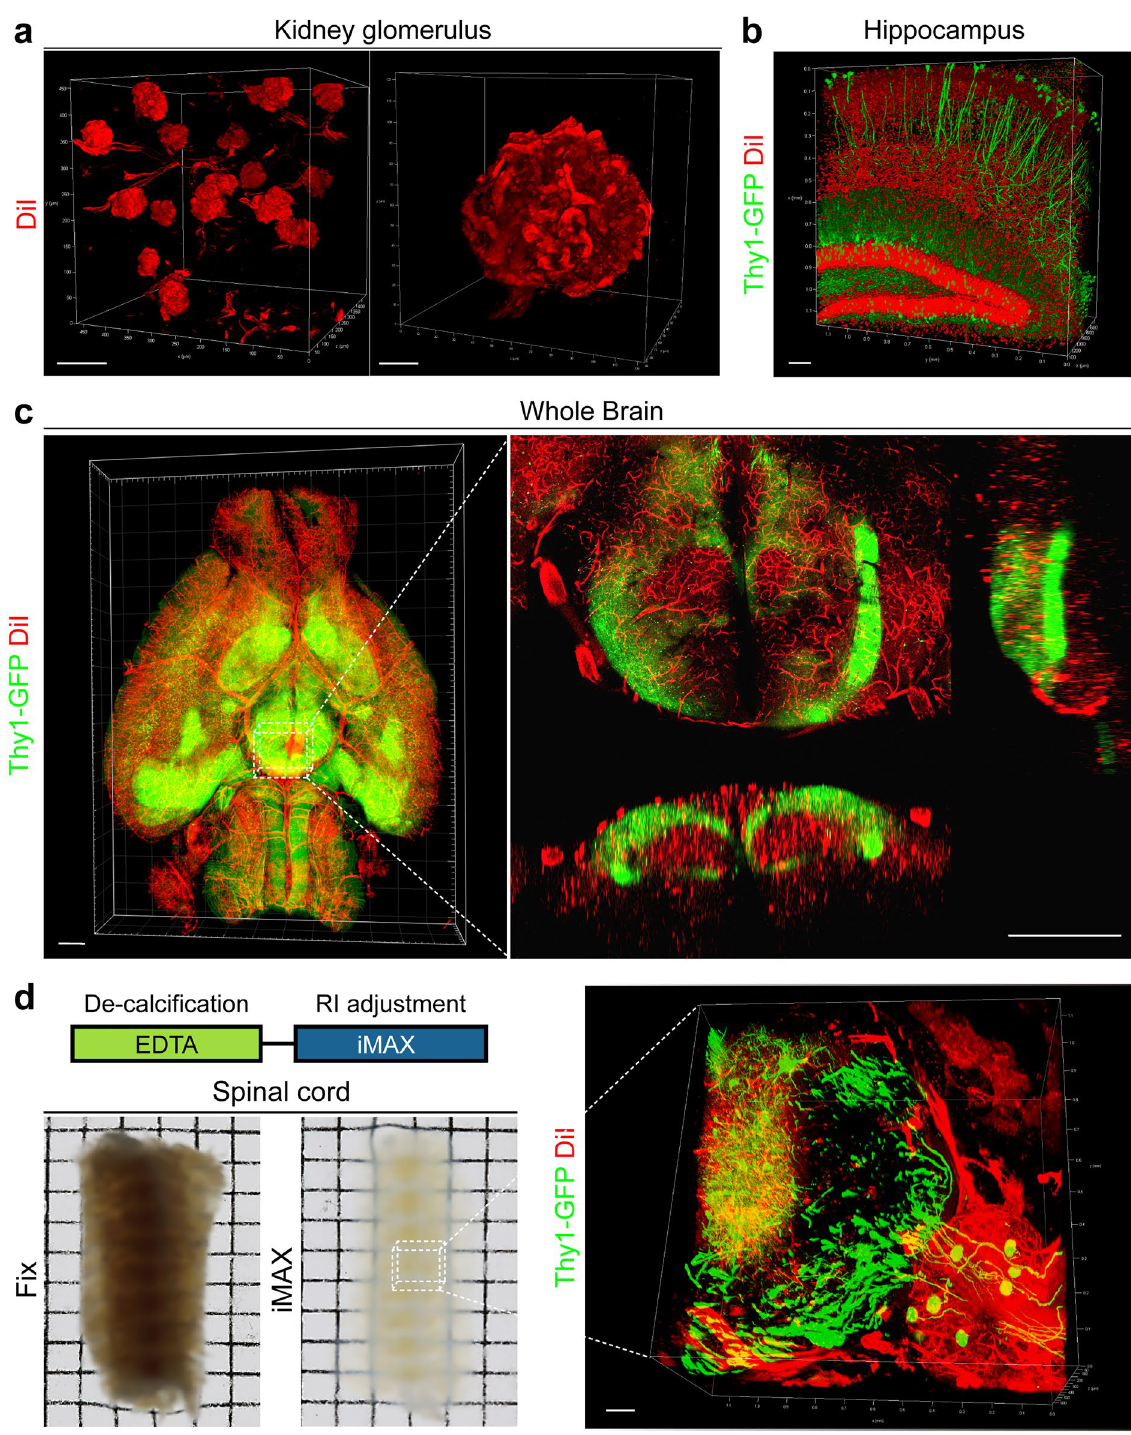
Figure 4. iMAX-based 3D imaging of the mouse organs. ( a ) Kidney glomeruli capillaries are visualized with CM-DiI infusion. Scale bar, 100 μm for left panel and 20 μm for right panel. ( b ) Green fluorescence protein (GFP) signals in the hippocampus of Thy1-GFP mice. Nuclei are counter-stained with PI. Scale bar, 100 μm. ( c ). Imaging of whole Thy1-GFP mouse brain. Red fluorescence was derived from the blood vessels pre-labeled by CM-DiI infusion. Right panel shows the orthogonal view of the ventral brain regions. Scale bars, 1 mm. ( d ) Imaging of spinal cord in the vertebrae. For the bone clearing, de-calcification was executed prior to the iMAX immersion. The specimen are placed on the 2-mm grid paper. Fluorescence signals from CM-DiI and Thy1-GFP are detected in the middle portion of the specimen as marked by black box. Scale bar, 100 μm. All fluorescent images were acquired using a TCS SP8 confocal laser-scanning microscope, and processed with Las X software ( a , b , d ) or Imaris ( c ) for 3D